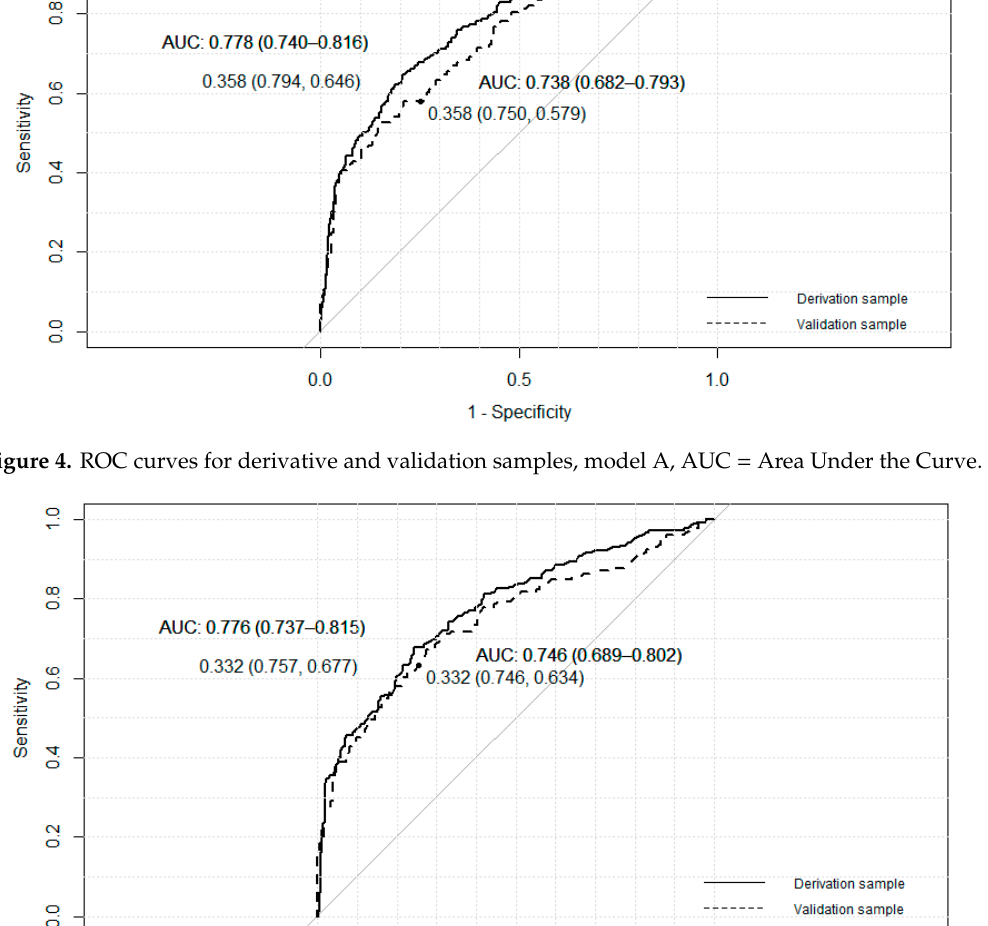
Figure 5. ROC curves for derivative and validation samples, model B, AUC = Area Under the Curve